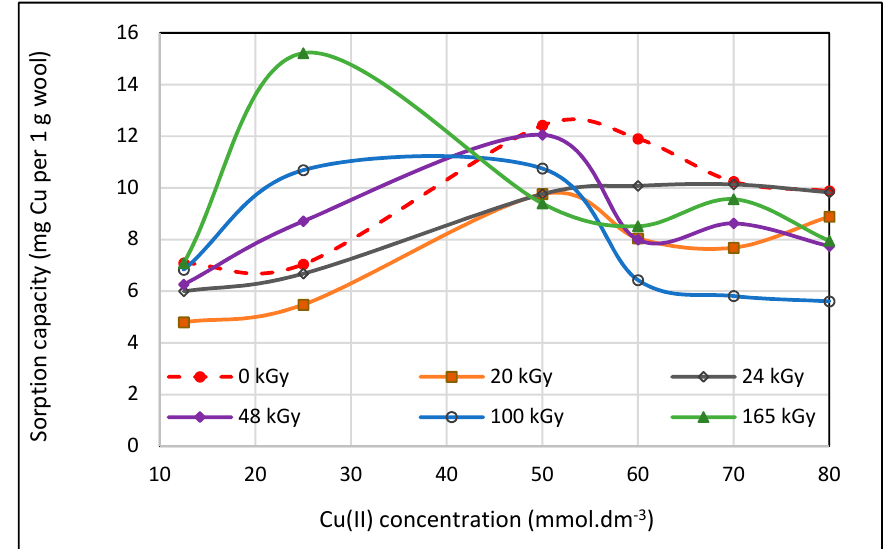
Figure 1. Variations of Cu(II) sorption onto irradiated sheep wool depending on concentration and absorbed dose.